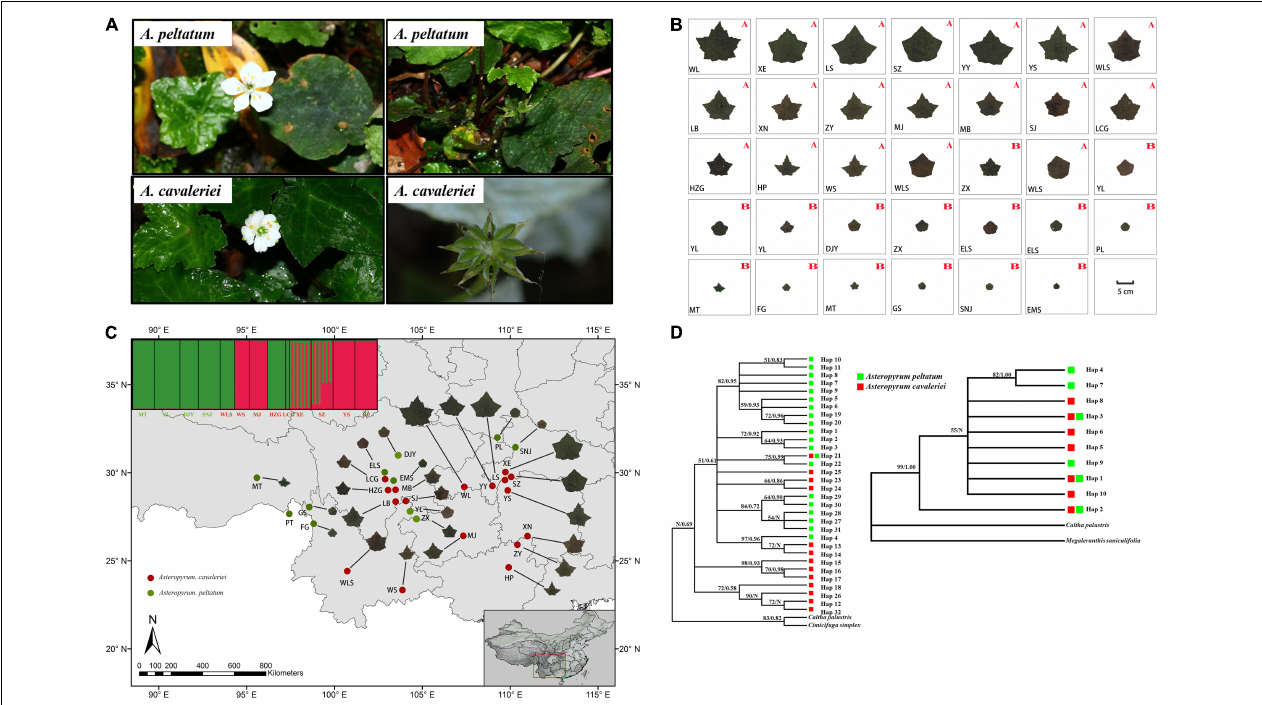
FIGURE 1 | The morphological characters of flowers and fruits (A) and the continuous morphological variation of leaf form in 27 populations of Asteropyrum (B) and their geographic distribution (C) , the capital letters A and B in (B) and the populations marked in red and green font in (C) represent A. cavaleriei and A. peltatum, respectively. Maximum likelihood and Bayesian consensus trees of nrITS2 ribotypes (left) and psb A- trn H chlorotypes (right) of Asteropyrum [ (D) , ML bootstrap values above 50% and posterior probability are shown on the branches, N represent low supporting values].